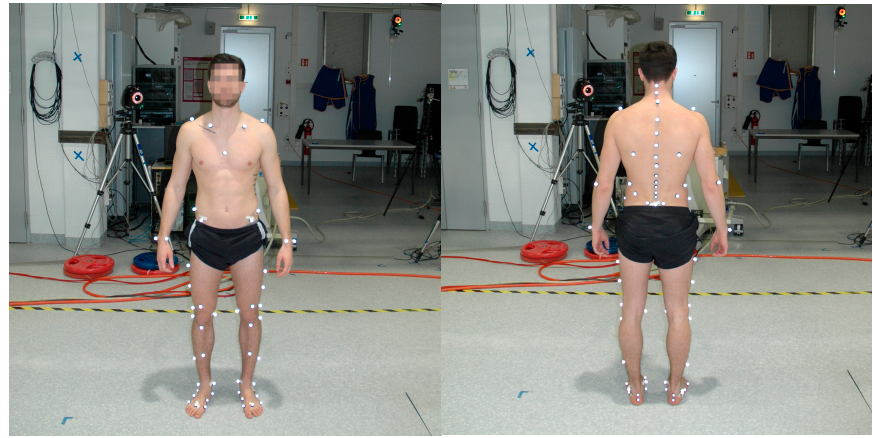
Figure A5. Subject with complete IfB marker set. On the left side: 55 markers on the legs, pelvis, shoulders and arms. On the right side: 22 markers on the back. Table A1. Range of motion (ROM) and standard deviation in the segments of the spine and in the shoulder joint for all subjects. Body weight (BW).